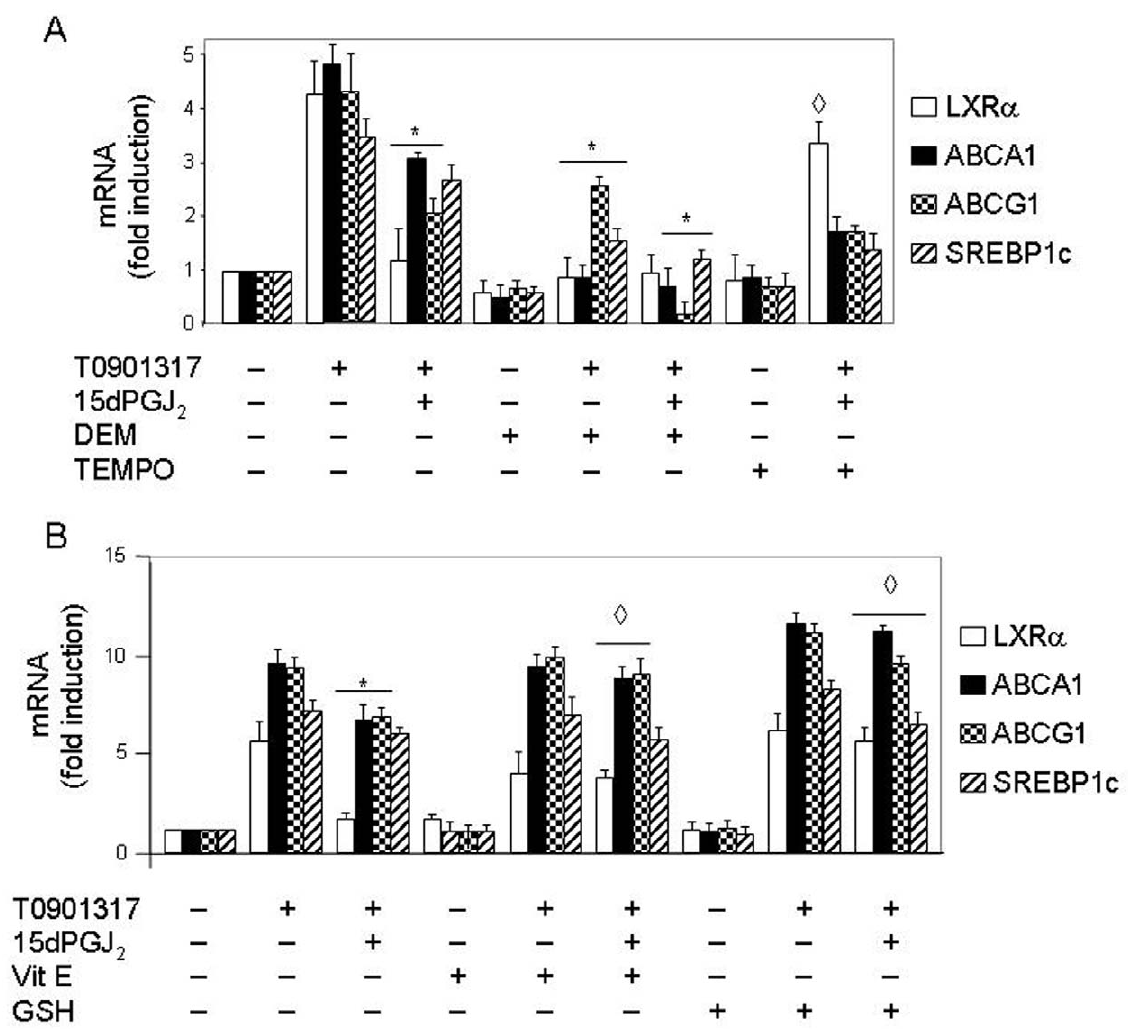
Figure 4. 15dPGJ 2 inhibition of LXR target genes mRNA expression is mediated by oxidative stress in human neutrophils. Neutrophils were preincubated at 37 u C with or without 10 m M DEM, 100 m M TEMPO (A), 100 m M vitamin E analog (Vit E) or 1 mM GSH (B) for 1 h. Then the cells were treated or not with 10 m M 15dPGJ 2 for 1 h, and thereafter stimulated or not with 1 m M T0901317 for 18 h. Finally, the levels of LXR a target genes mRNAs were analyzed by real time RT-PCR. Statistical data (mean 6 SEM, n=3) were corrected for differences in b -actin mRNA levels and expressed as fold induction. * P , 0.01 for T0901317–stimulated, 15dPGJ 2 (A and B) or DEM (A)-treated versus -untreated. e P , 0.01 for 15dPGJ 2 and T0901317-stimulated, TEMPO (A), Vit E or GSH (B)-treated versus -untreated.